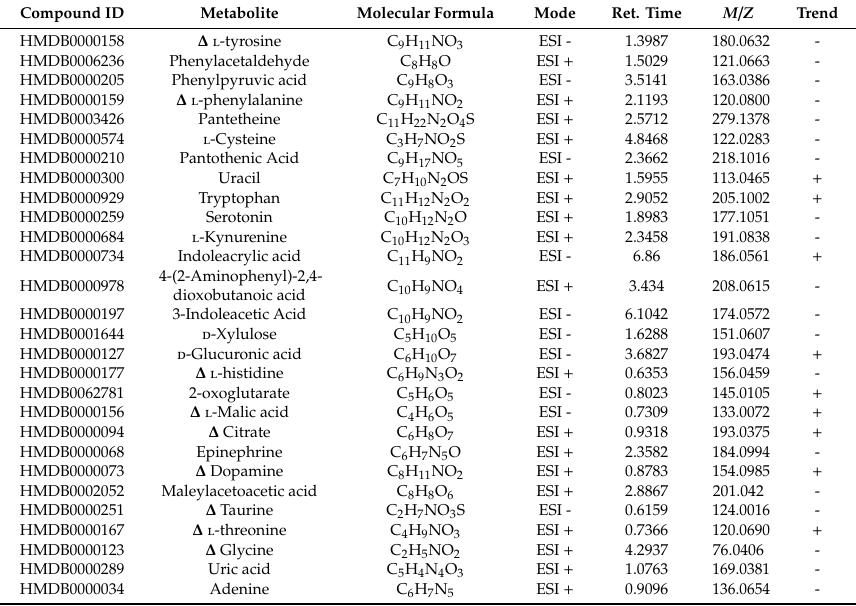
Table 1. Di ff erential Metabolite Pathway Analysis Results.